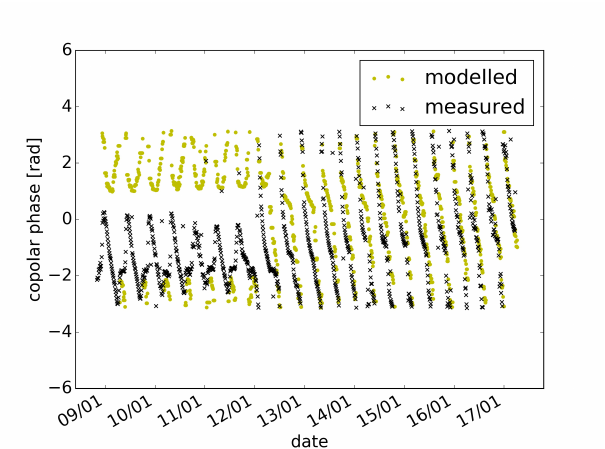
Figure 9. Time series of modelled and measured copolar phase variations induced by changes of the Davosersee lake surface level on a corner reflector.